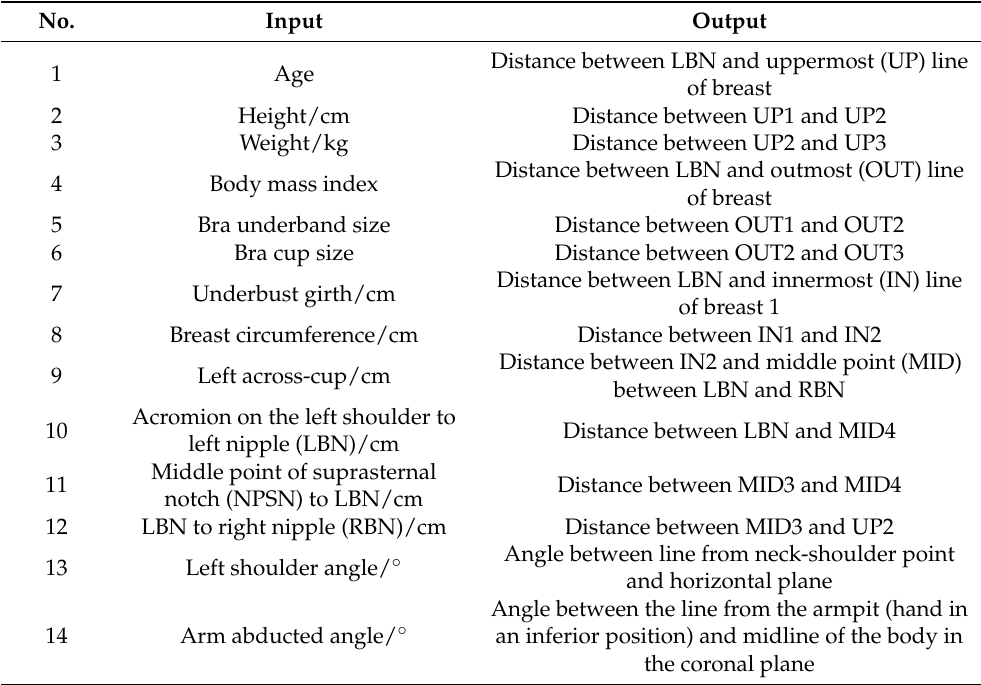
Table 2. Preliminary inputs and outputs for machine learning